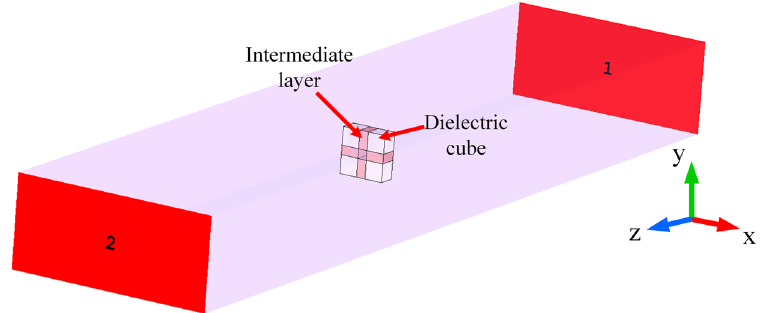
Figure 1. Schematic of the model meta-atom and test environment used in the